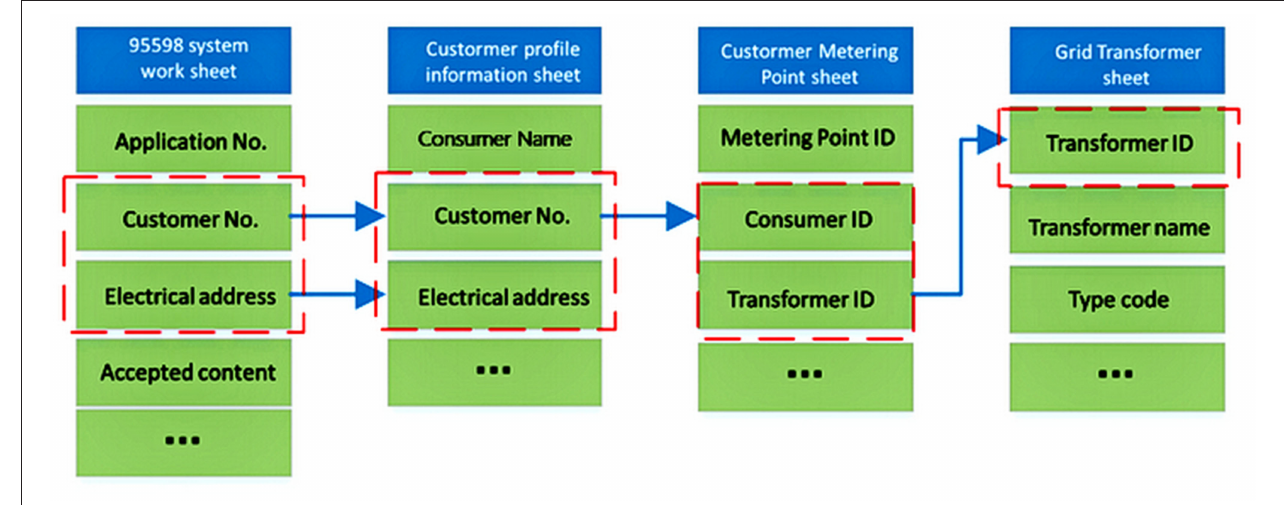
FIGURE 1 | Model of customer demands associated with power grid